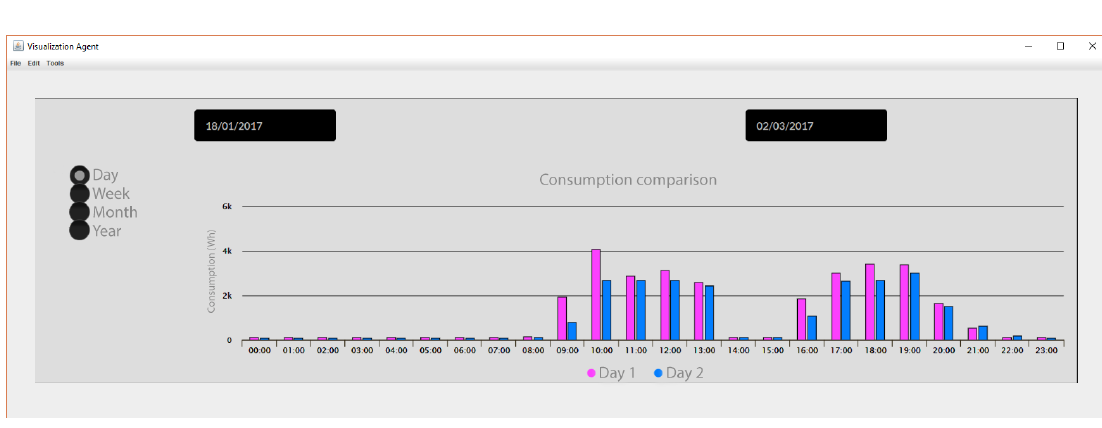
Figure 17. Energy consumption comparison at Office 4 by Visualization agent.